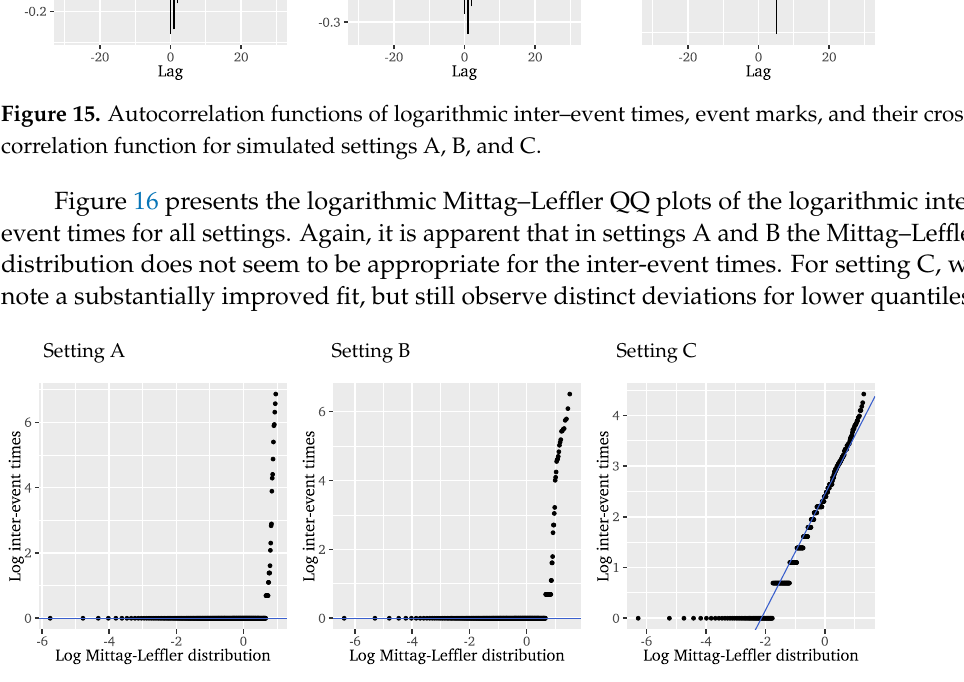
Figure 16. Logarithmic Mittag–Leffler QQ plot of the logarithmic inter–event times for simulated settings A, B, and